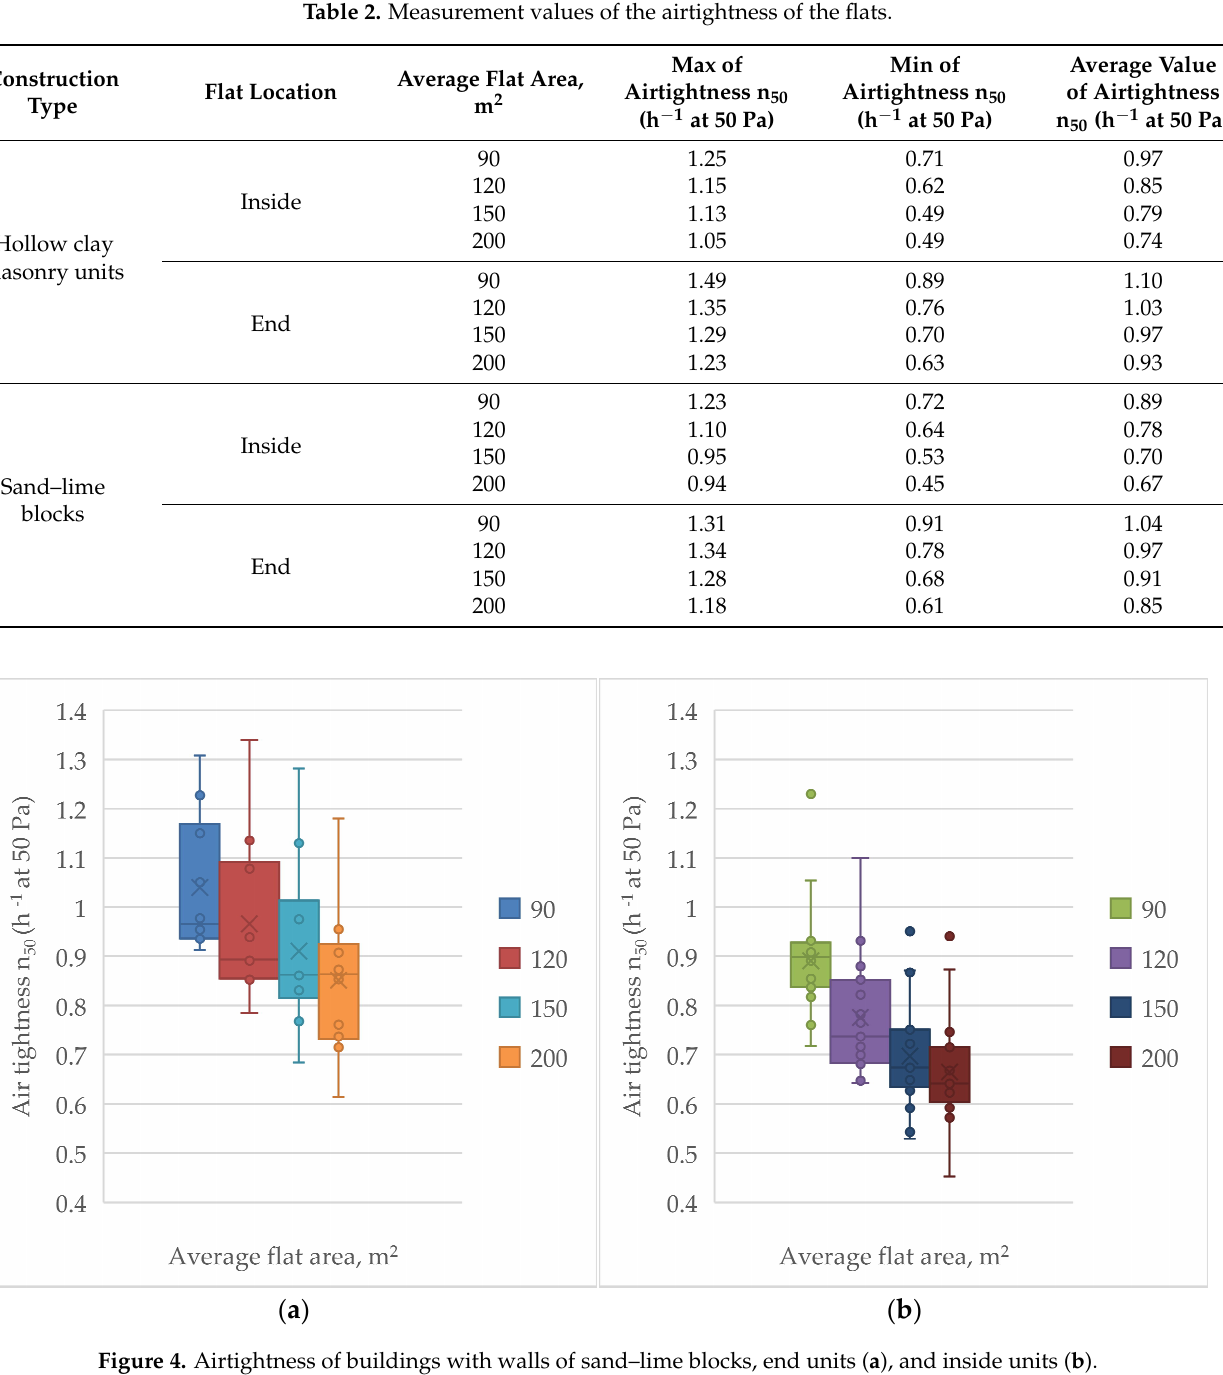
Figure 4. Airtightness of buildings with walls of sand–lime blocks, end units ( a ), and inside units ( b ). The general analysis and comparison of the data shows that the average values of airtightness in end units are 20% higher than the values in inside units of the same type. Based on the research results, mathematical dependencies were derived to be used for the forecasting of airtightness values for the flats with various floor areas (Figure 5).